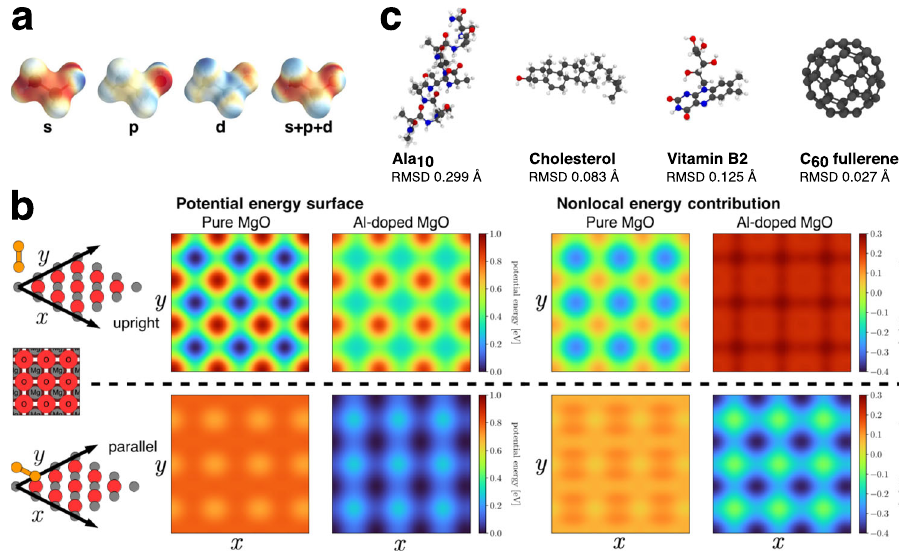
Fig. 2 Examples of chemical insights extracted by SpookyNet. a Visualization of the learned local chemical potential for ethanol (see methods). The individual contributions of s-, p-, and d-orbital-like interactions are shown (red: low energy, blue: high energy). b Potential energy surface scans obtained by moving an Au 2 dimer over an (Al-doped) MgO surface in different (upright/parallel) con fi gurations (the positions of Mg and O atoms are shown for orientation). SpookyNet learns to distinguish between local and nonlocal contributions to the potential energy, allowing it to model changes of the potential energy surface when the crystal is doped with Al atoms far from the surface. c A model trained on small organic molecules learns general chemical principles that can be transferred to much larger structures outside the chemical space covered by the training data. Here, optimized geometries obtained from SpookyNet trained on the QM7-X database (opaque in color) are shown and compared with reference geometries obtained from ab initio calculations (transparent in gray). As indicated by the low root mean square deviations (RMSD), geometries predicted by SpookyNet are very similar to the reference.